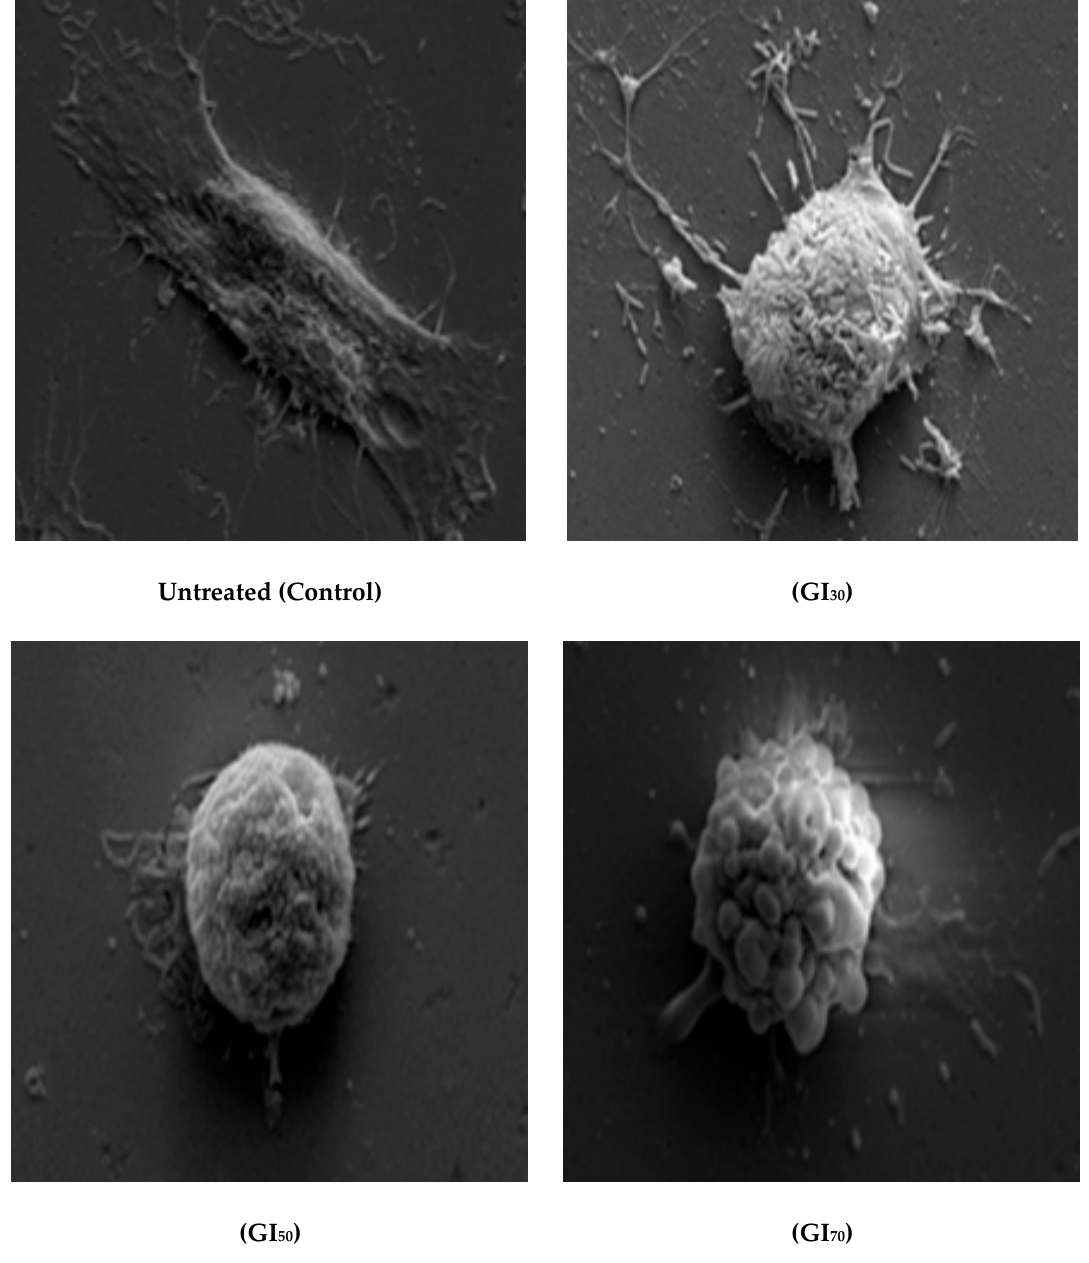
Figure 11. Scanning Electron Micrographs (SEM) of MG-63 cells before and after treatment with different concentrations of Epiafzelechin from C. fistula (Magnification of 14 KX, 14,000 times).